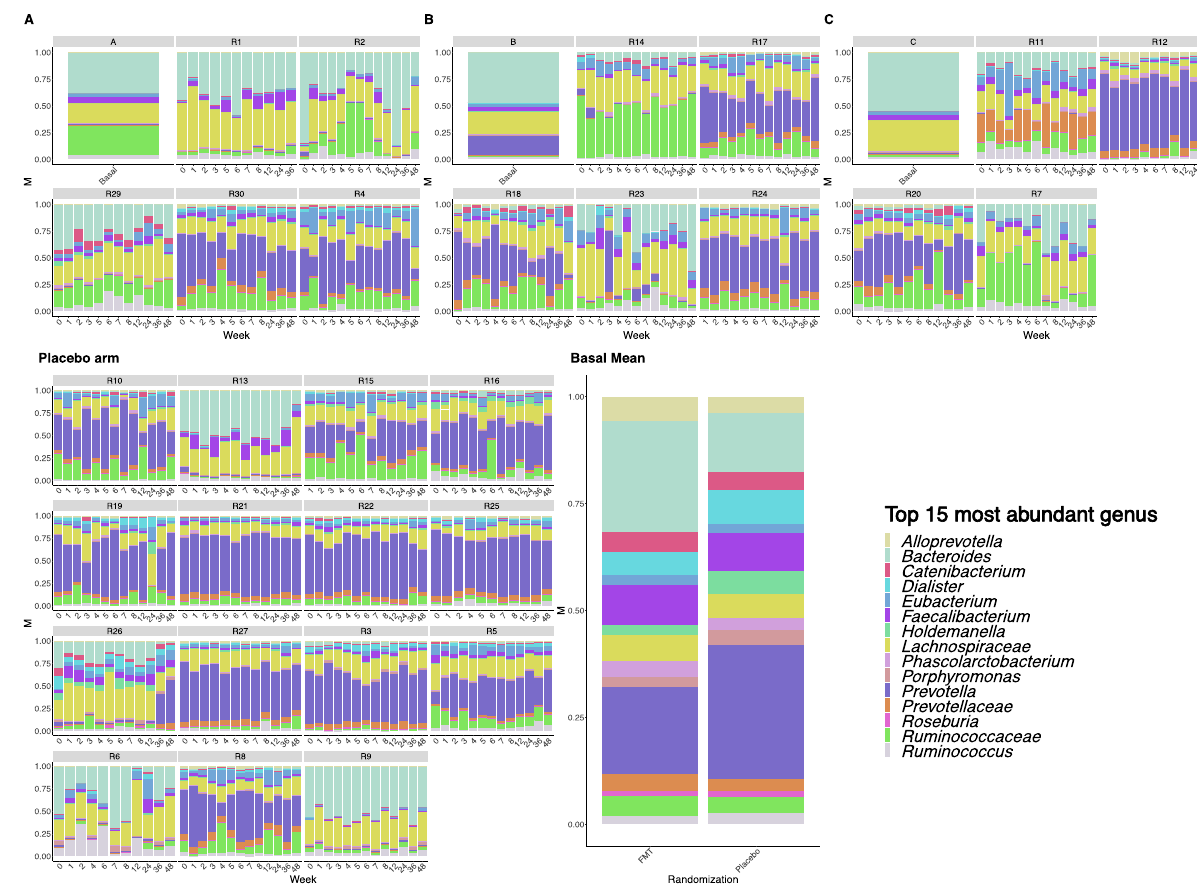
Fig. 4 Taxonomic composition of the top 15 most abundant genus. Each plot represents one study subject. Within each plot, bars represent independent measurements over time. Individuals grouped by donor A , B or C , or placebo are represented in the respective panels, in which the columns A , B and C denote the microbiota composition of donors A , B and C , respectively. The panel “ basal mean ” represents the mean abundance at baseline in the FMT and placebo groups. n = 369 biologically independent samples from 14 individuals in the FMT group, 15 individuals in the placebo group, and 3